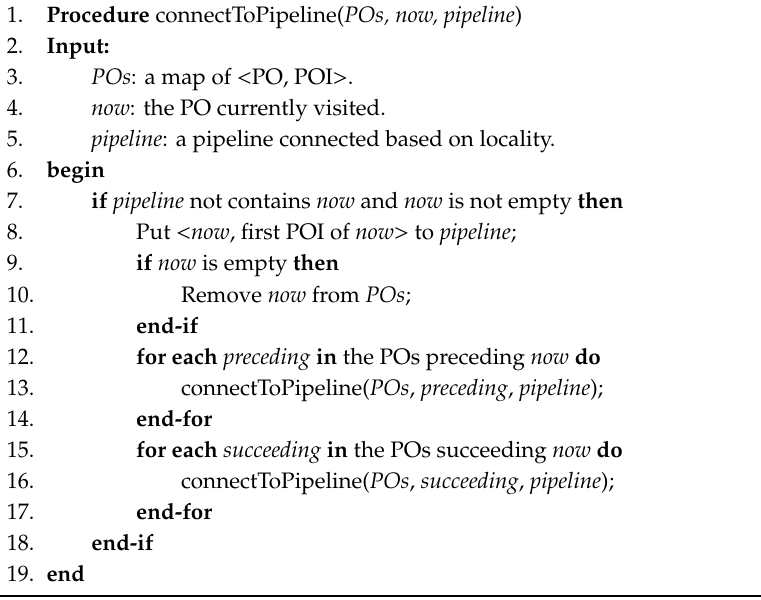
Algorithm 4 Procedure connectToPipeline() to connect POIs into a pipeline